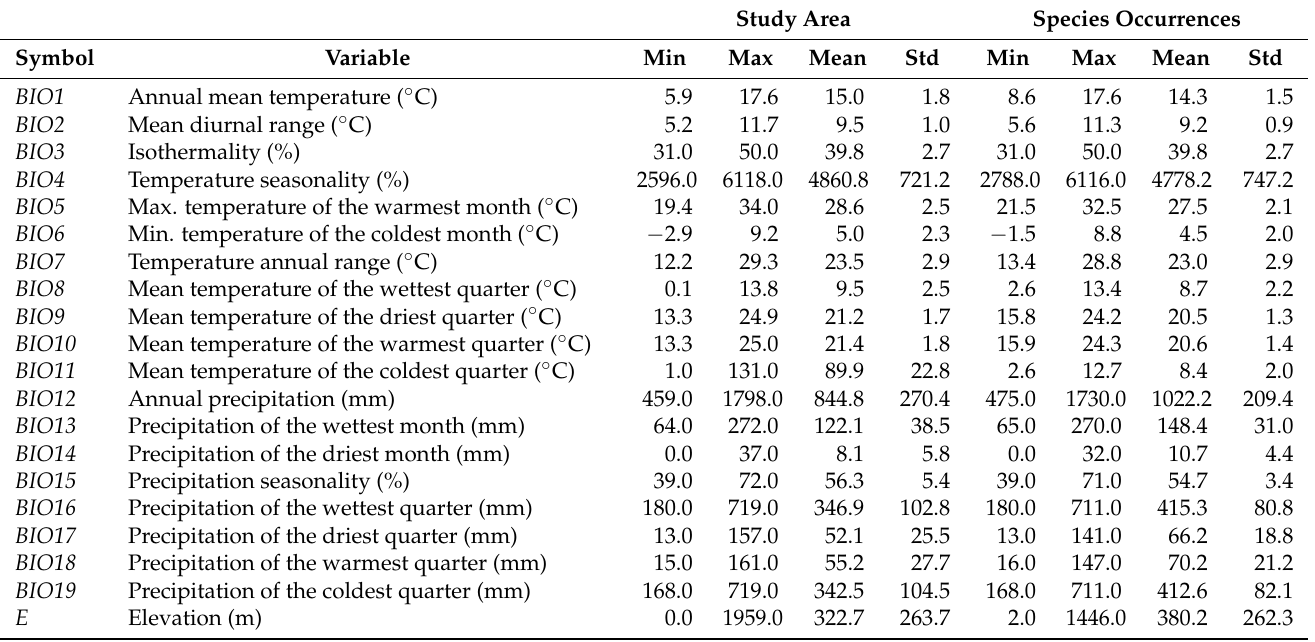
Table 1. Summary statistics for bioclimatic and elevation variables for the study area and species occurrences. Study Area Species Occurrences